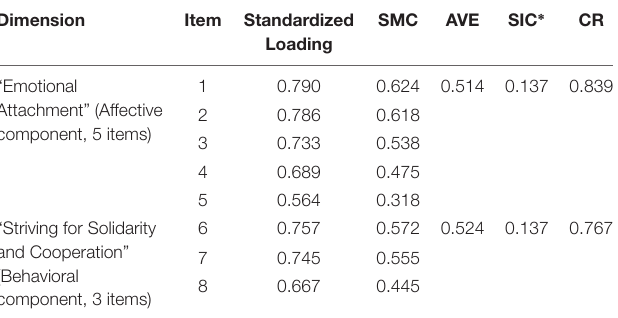
TABLE 4 | Confirmatory factor analytic findings of the bi-dimension correlated model of the COIQ (Study 1, n Study 1 − CFA = 205). Dimension